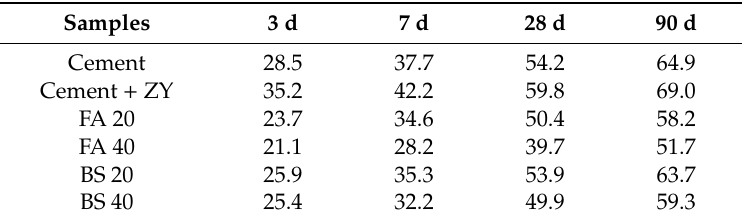
Table 4. Compressive strength (MPa) of mortars cured at 293 K with di ff erent scheduled periods.